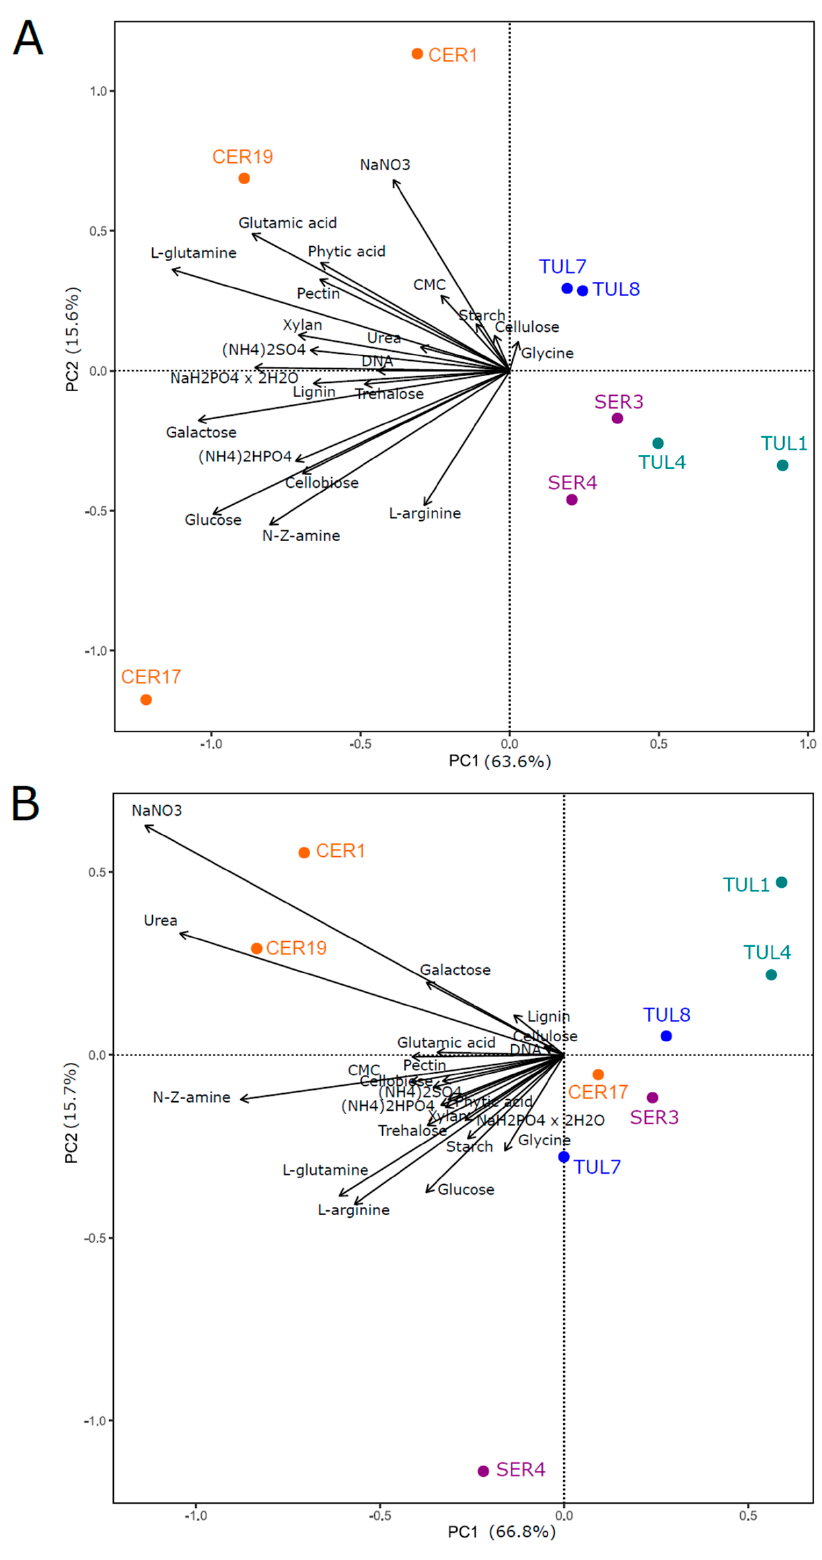
Figure 3. Principal components analysis of the fungal biomass of nine fungal isolates cultivated in solid ( A ) or in liquid ( B ) media, containing the 22 different carbon, nitrogen, and phosphorus sources (see Table S1 for details). The colour of the isolates indicates the fungal group: orange, purple, blue and green for Ceratobasidiaceae (CER1, 17, 19), Serendipitaceae (SER3, 4), Tulasnellaceae clade A (TUL1, 4) and Tulasnellaceae clade B (TUL7, 8), respectively.